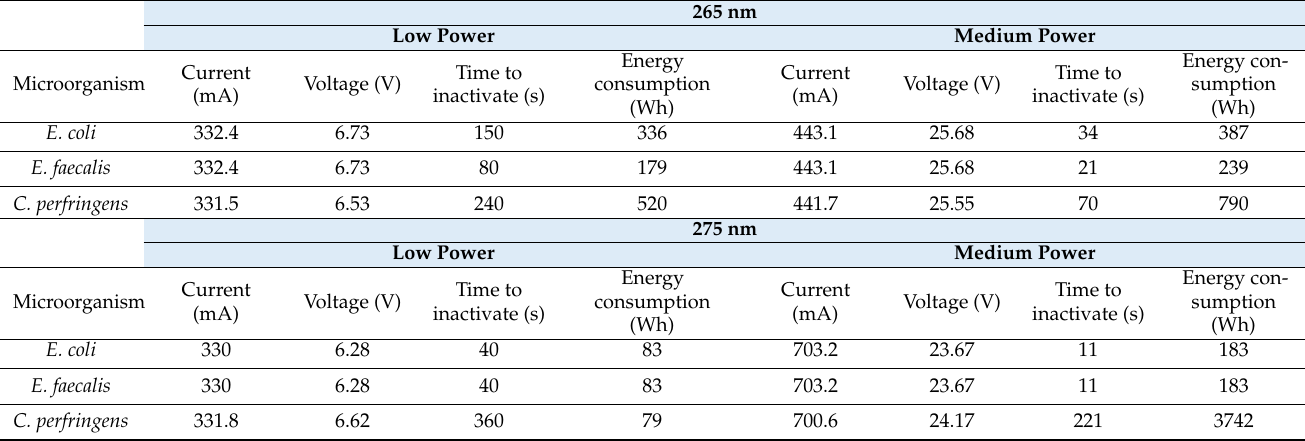
Table 6. Energy consumption for different bacteria using 265 nm and 275 nm wavelengths. 265 nm Low Power Medium